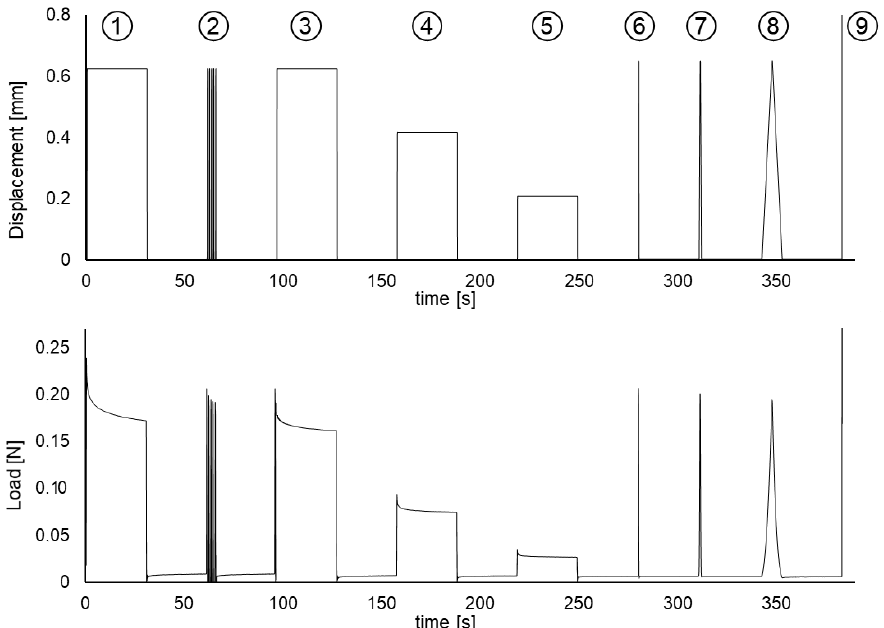
Figure 6. Mechanical tests showing viscoelastic effects: (1) initial relaxation test, (2) cyclic loading showing preconditioning, (3–5) repeated relaxation tests, (6–8) triangular wave loading, and (9) stretch to